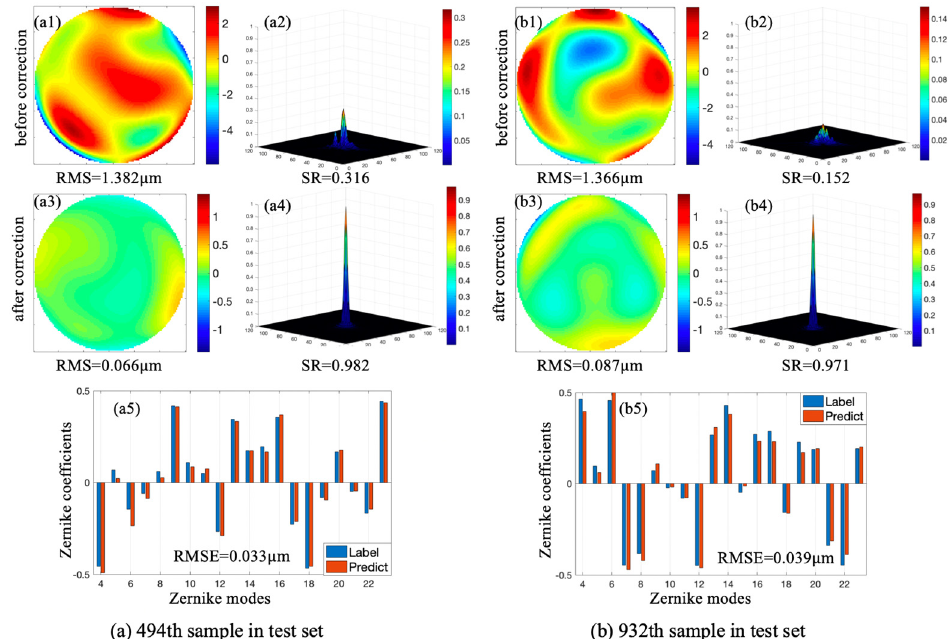
Figure 5. Correction results of 494th ( a ) and 932nd ( b ) samples in test set.